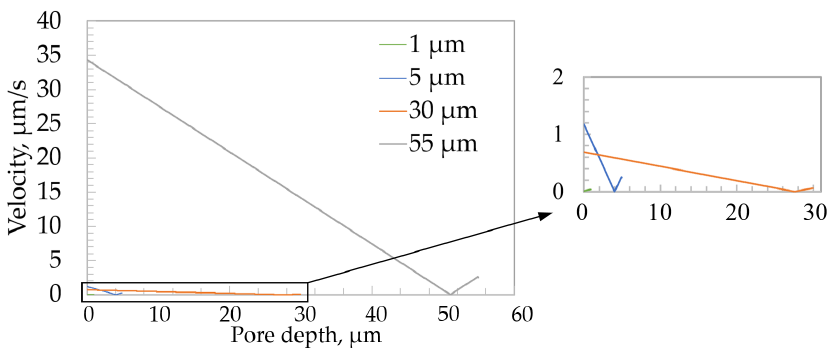
Figure 4. Comparative velocity curves of different pore depths.